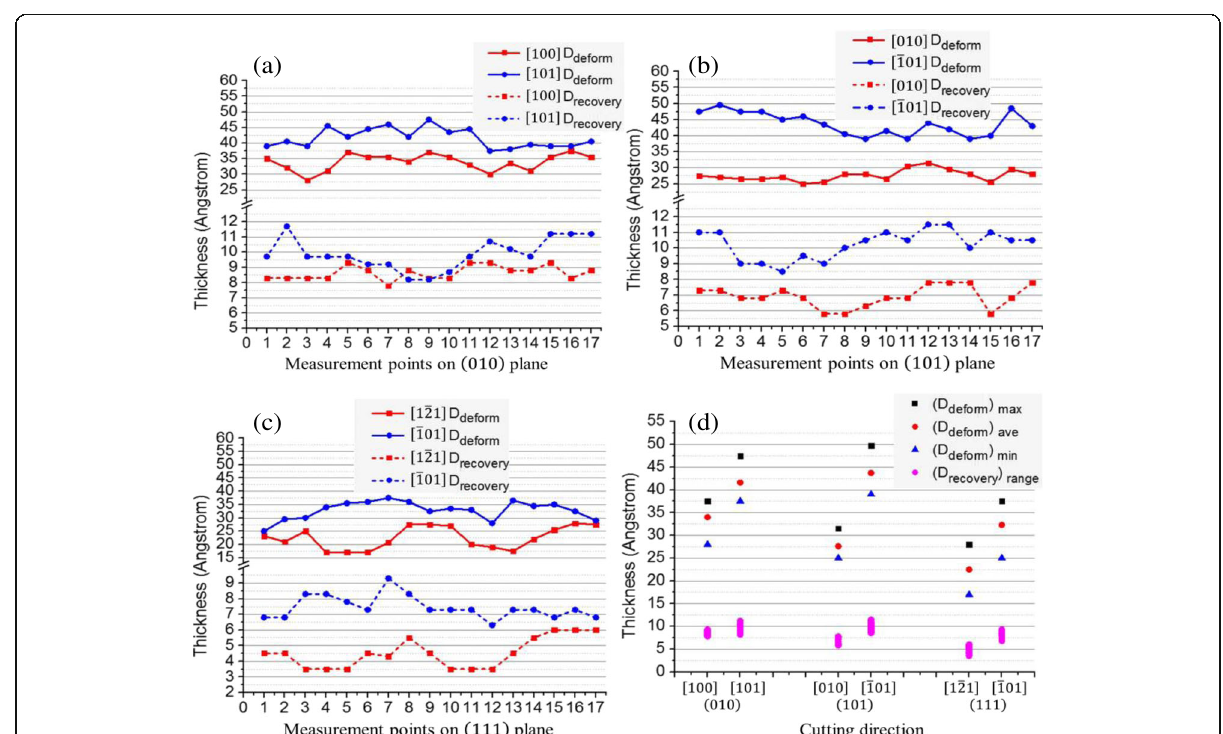
Fig. 12 The thickness of deformed layer ( D deform ) and recovery height ( D recovery ) with different cutting orientations. a Cutting alone the [100] and (cid:1) [101] direction on the (010) plane. b Cutting alone the [010] and 101 direction on the (111) plane. d The maximum, average, and minimum values of D deform and the range of D